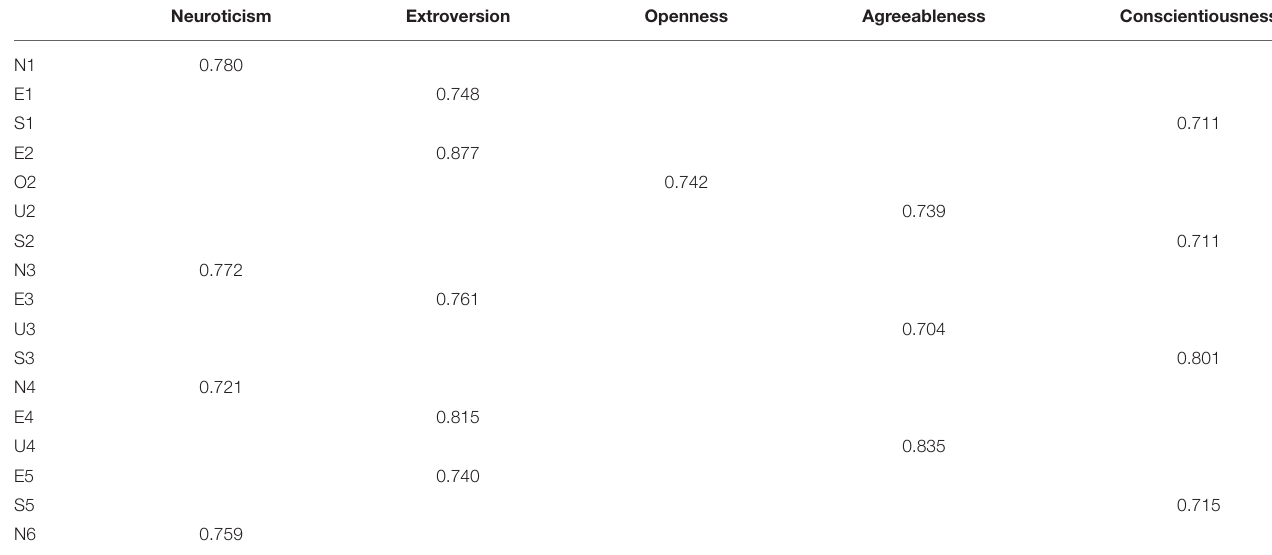
TABLE 5 | Correlation between the dimensions of the NEO-Pi-R questionnaire and their subscales.